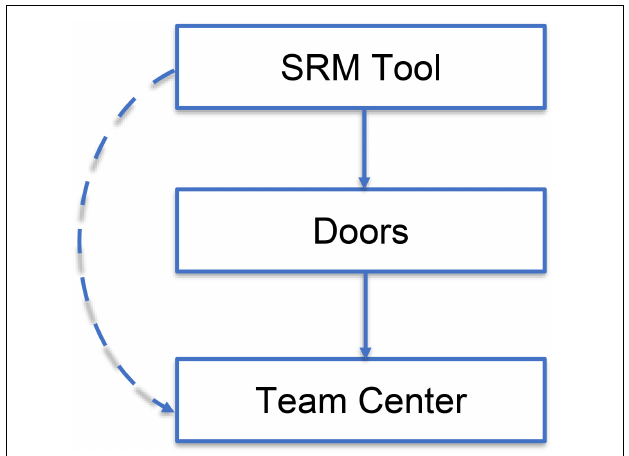
FIGURE 2 | Replica of the picture on the board.